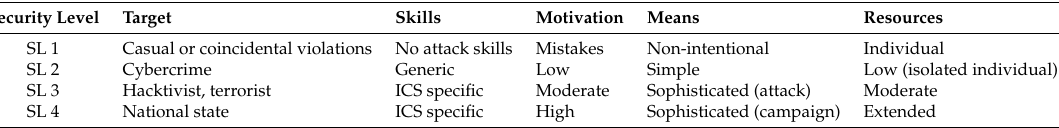
Table 1. Security levels (SL) defined by IEC 62443